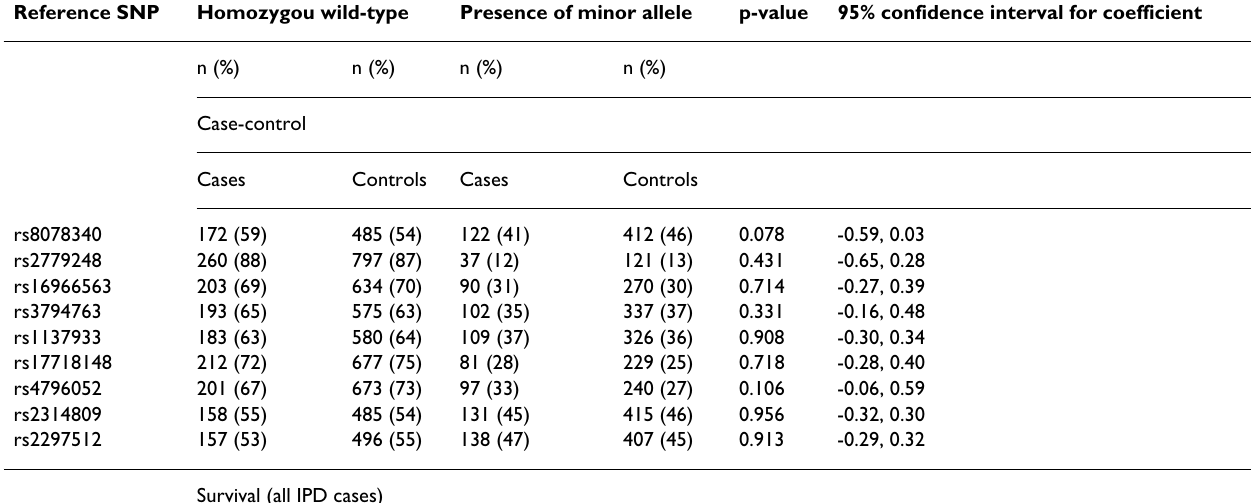
Table 2: Comparison of NOS2A htSNP allele frequencies between cases and controls and survival in